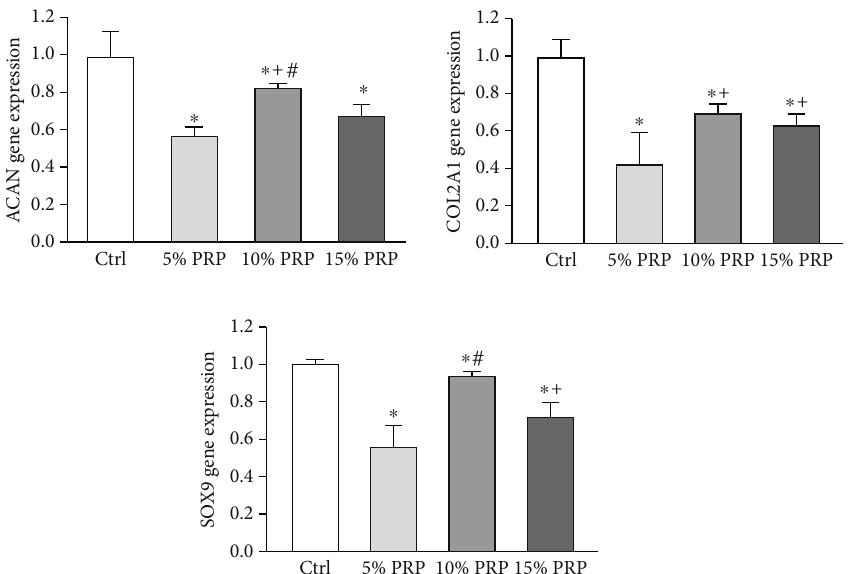
Figure 4: Expression of cartilage-speci fi c genes in the four groups following 21-day culture. Ctrl: commercial chondrogenic di ff erentiation medium. ∗ P < 0 : 05 compared to control group, + P < 0 : 05 compared to 5% PRP group, # P < 0 : 05 compared to 15% PRP